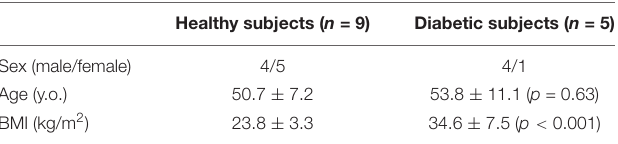
TABLE 1 | Demographic characteristics of healthy and diabetic subjects ( p -values for differences in age and BMI are given) included in the study (Ref. ClinicalTrials.gov no.